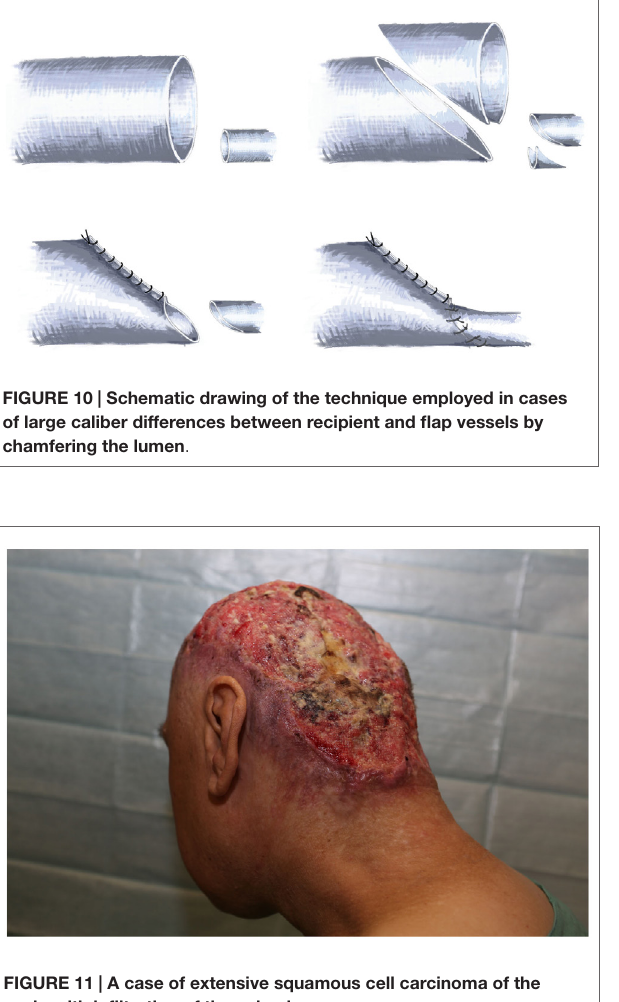
FiGURe 11 | A case of extensive squamous cell carcinoma of the scalp with infiltration of the calvarium .